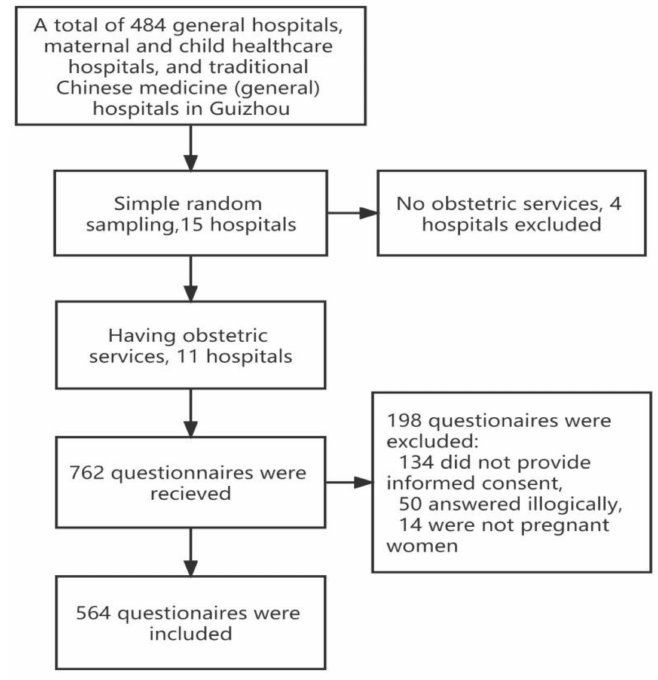
Figure 1. Flow chart detailing processes of the study.